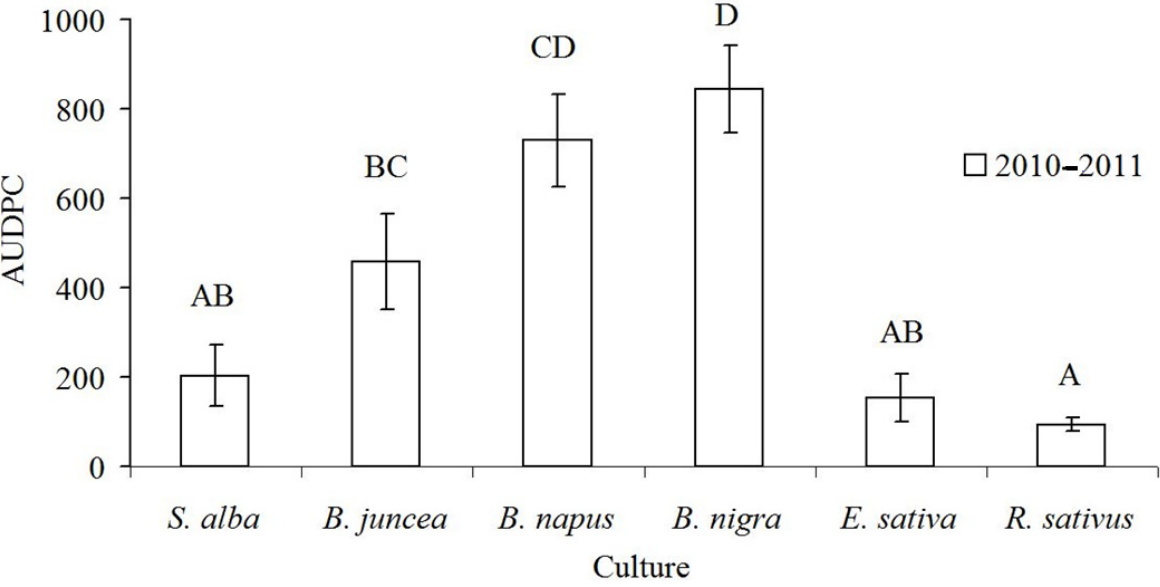
Figure 3. Mean area under the disease progress curve (AUDPC) of Alternaria black spot ( A. brassicae ) infection in different cruciferous oilseed crops (averages for the two study years). Error bars denote the standard error of the means. Means followed by different capital letters (A–D) above each bar indicate a significant influence ( p < 0.05) of cruciferous oilseed crop species (Tukey HSD test). Table 4. Impact of study year and species and their interaction on Alternaria black spot ( A. brassicae ) AUDPC values according to a two-way ANOVA.